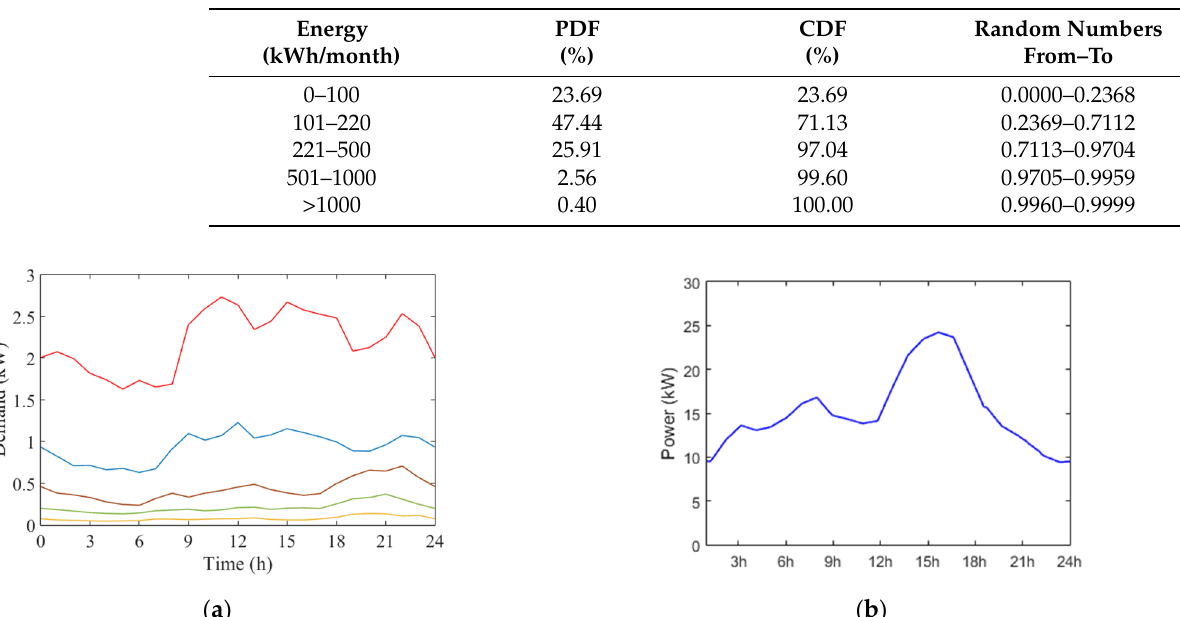
Figure 2. ( a ) Residential monthly typical consumption curves; and ( b ) transformer base load.